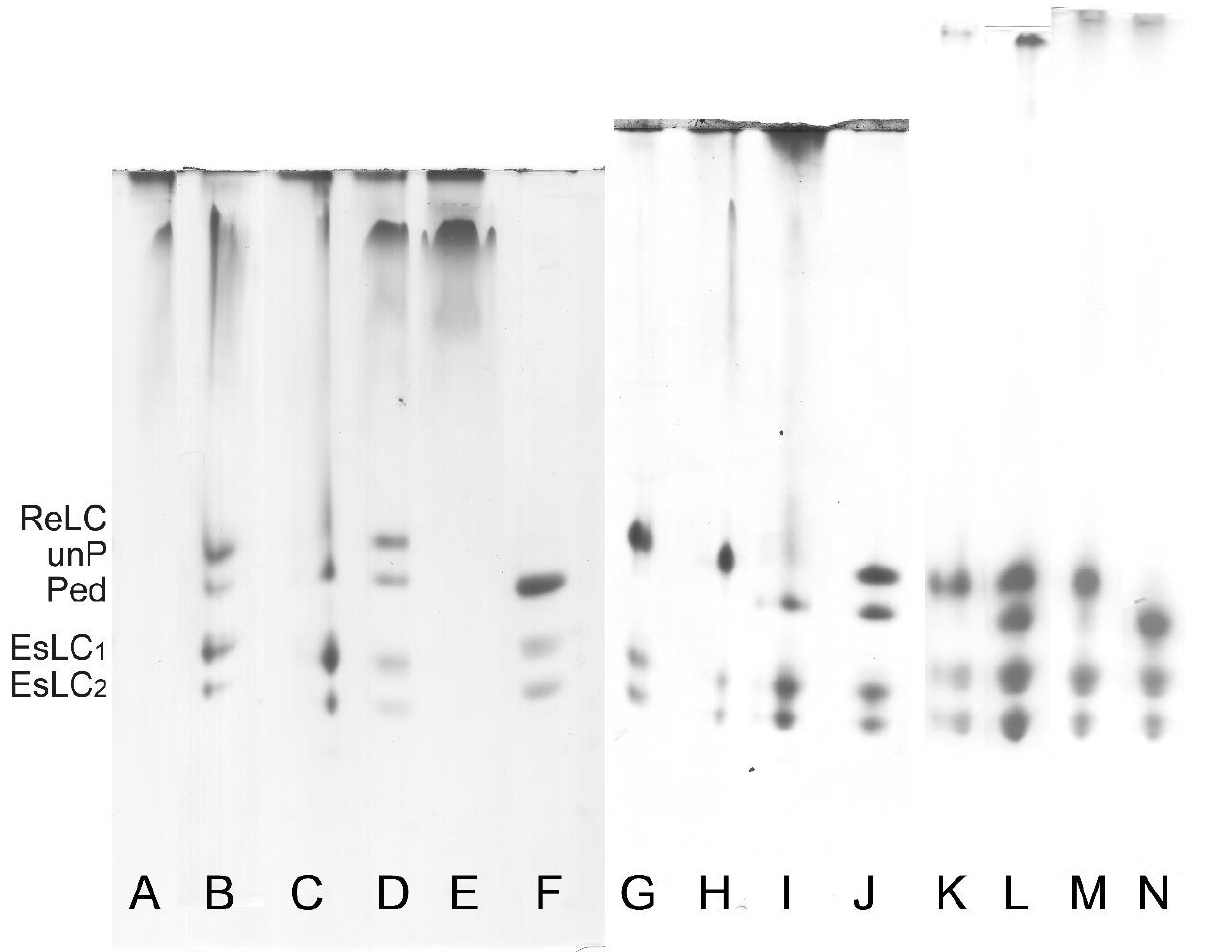
Figure 6. Analysis of phosphorylation levels of ReLC by UG PAGE of three different myosin preparations. As indicated by the labels on the left, the top bands correspond to unphosphorylated (unP) ReLC. The bands below the unphosphorylated bands correspond to phosphorylated (Ped) ReLC. The bottom two bands correspond to the two differently charged isoforms of EsLC, which are not phosphorylated. The first preparation (lanes A – E ) was bovine tracheal smooth muscle myosin purified using the standard protocol developed for gizzard smooth muscle. The second preparation (lanes G – J ) was bovine tracheal smooth muscle myosin purified using the protocol optimized for bovine tracheal smooth muscle. The third preparation (lanes K – N ) was pig stomach muscle myosin purified using the protocol optimized for bovine tracheal smooth muscle. ( A ) Crude actomyosin. ReLC and EsLCs did not enter the separation part of the gel containing glycerol because they were not dissociated from the myosin heavy chains [29]. ( B ) Freshly prepared CMY supernatants. ( C ) CMY pelleted filaments. In lane B and C, ReLC and EsLC entered the gel but with significant smearing. ( D ) CMY supernatant left on ice overnight. ReLC and EsLC migrated into UG PAGE and the characteristic TM smearing band is visible at the top of the lane. ( E ) Supernatant of D after pelleting of the myosin filament. The only band visible in lane E is TM because the soluble TM remained in the supernatant after the removal of the myosin filaments. ( F ) Phosphorylated purified myosin from turkey gizzard included for comparison. ( G ) Freshly prepared CMY supernatant. ( H ) Pelleted filaments of the dialyzed CMY fraction. ( I ) CMY supernatant left on ice overnight. ( J ) Supernatant of I after pelleting of the myosin filament. Analogous purified myosin preparations were obtained from other types of smooth muscle, i.e., the antrum phasic (lanes K , L ) and fundus tonic (lanes M , N ) muscles of pig